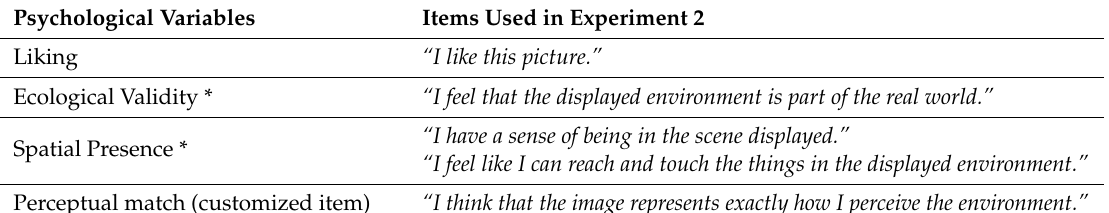
Table 2. The table lists all items used for the questionnaire in Experiment 2. The second and the third row report items selected from the * SOPI inventory; the fourth row reports the customized item. Psychological Variables Items Used in Experiment 2